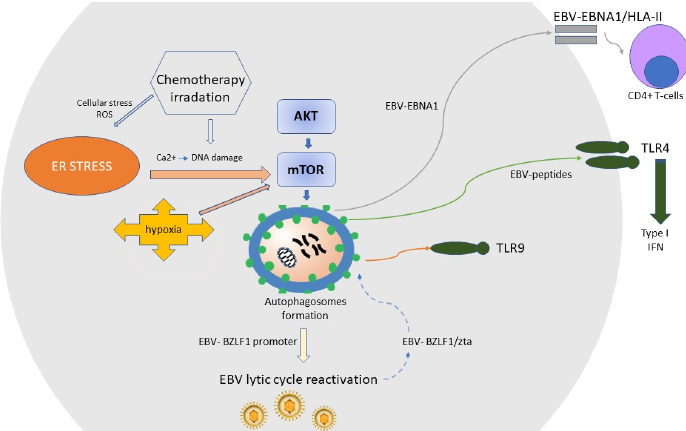
Figure 3. The cellular degradation pathway of autophagy plays a fundamental role in immunity. Environmental perturbations (endoplasmic reticulum (ER) stress, hypoxia) as well as chemotherapy and radiation, by inducing DNA damage and cellular stress, inhibit AKT/mammalian target of rapamycin (mTOR) and activate autophagy. The autophagy machinery interfaces with most immune signaling molecules involved in the development, homeostasis, and survival of inflammatory cells, including macrophages, neutrophils, T lymphocytes, and B lymphocytes. Disturbance of ER homeostasis that cannot be rescued by the unfolded protein response (UPR) results in autophagy, which is largely attributed to the inactivation of the mTOR and downregulation of AKT/mTOR pathway, which is an important signaling pathway in the development of GC. Autophagy is necessary for recognition of the EBV-EBNA1 antigen by CD4 + T cells via HLA-II and EBV-mediated activation of the Toll-like receptor (TLR) and plays a role in the reactivation of the EBV lytic cycle. The EBV-BZLF1 protein, also known as Zta, creates a positive loop with autophagosomes to maintain the EBV lytic cycle. IFN, type I